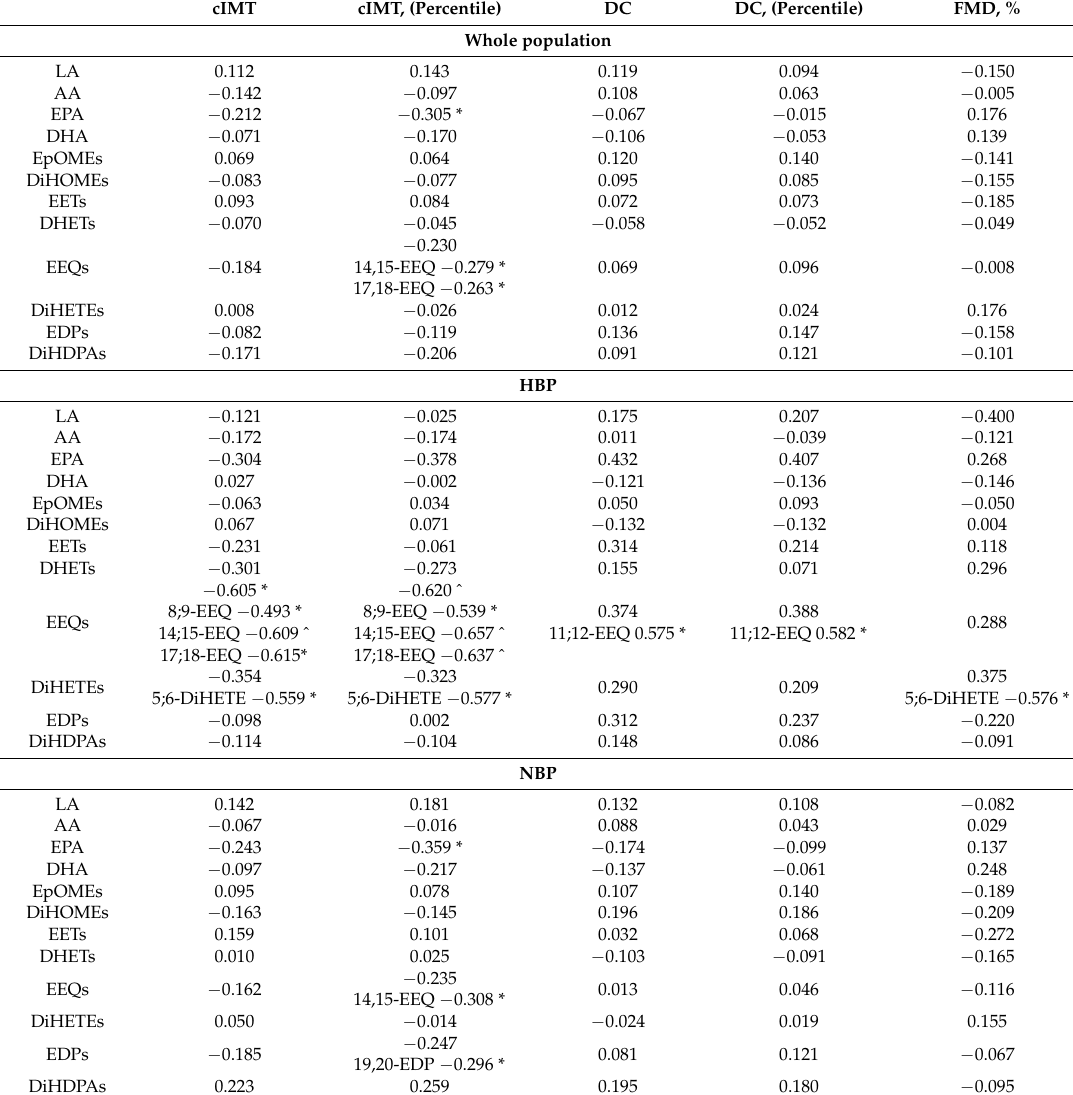
Table 5. Correlations of LA, AA, EPA, DHA and the derived CYP450-epoxygenase/sEH metabolites with vascular tests in the whole sample and in the two individual subgroups of HBP and NBP obese children. cIMT cIMT, (Percentile) DC DC, (Percentile) FMD, % Whole population